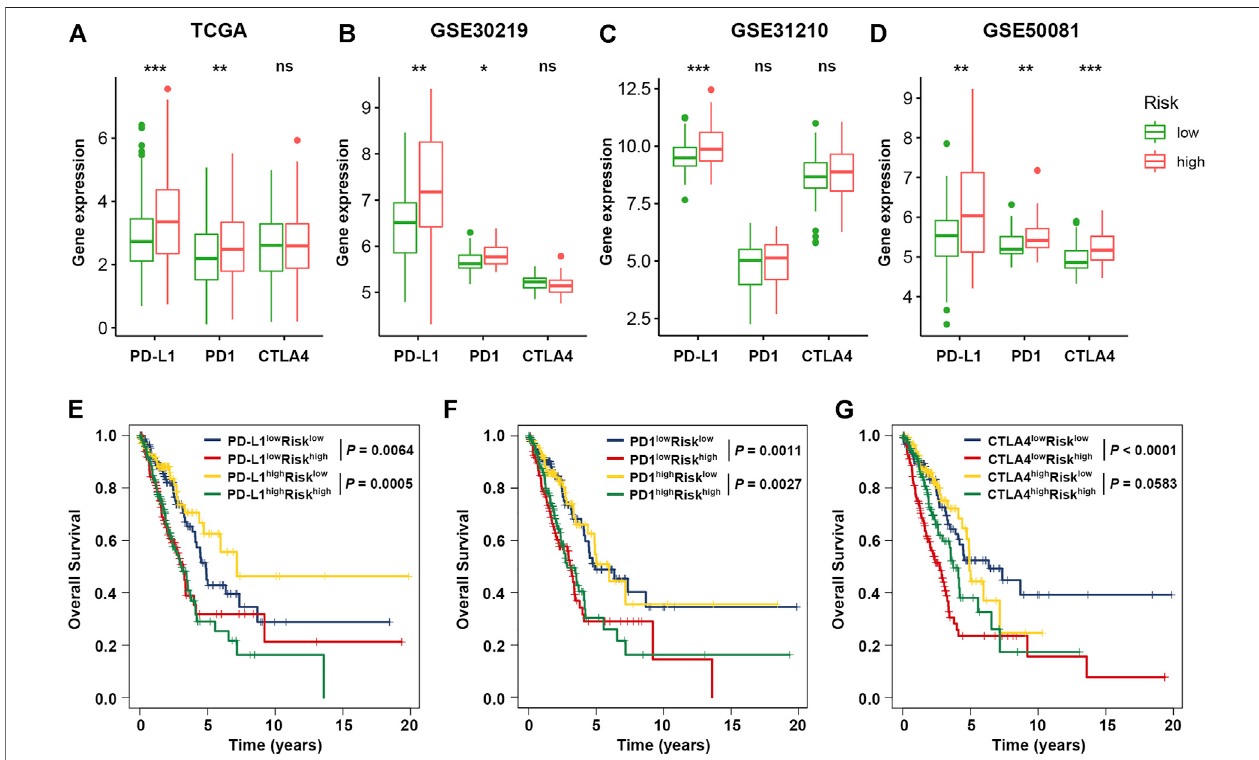
FIGURE 6 | Impact of immune checkpoint genes and SRS on clinical outcome. (A – D) . Comparison of the expression levels of immune checkpoint genes (PD-L1, PD1, and CTLA4) between the high- and low-risk groups in the training and validation cohorts. (E – G) . Kaplan-Meier survival curves of OS among four patient groups divided by the SRS and PD-L1, PD-1, or CTLA-4. *, **, and *** represent P < 0.05, P < 0.01, and P < 0.001, respectively.